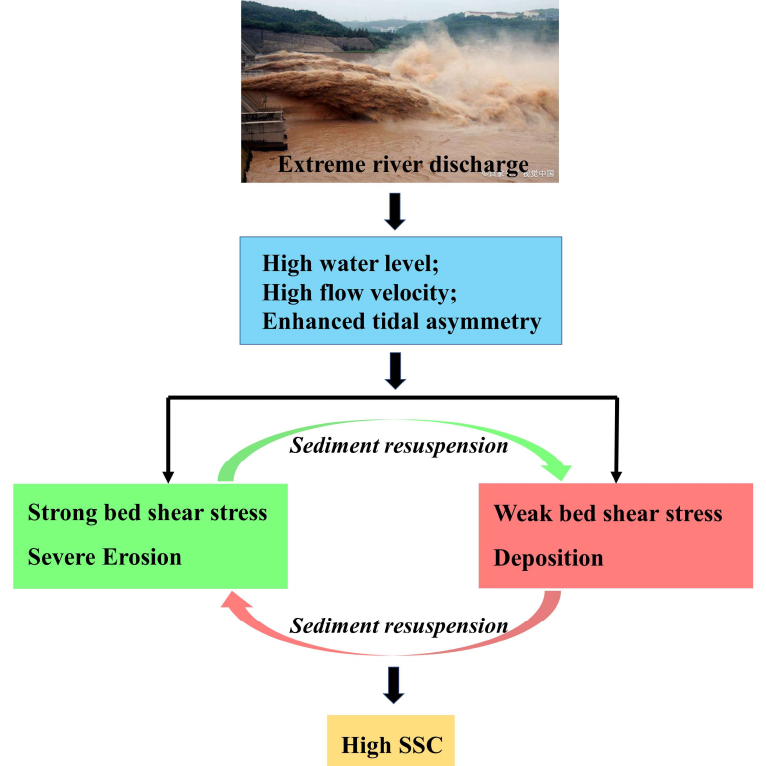
Figure 14. A straightforward conceptual model of hydrodynamics, sedimentary dynamics, and morphological variations induced by high-energy riverine flow. morphological variations induced by high-energy riverine